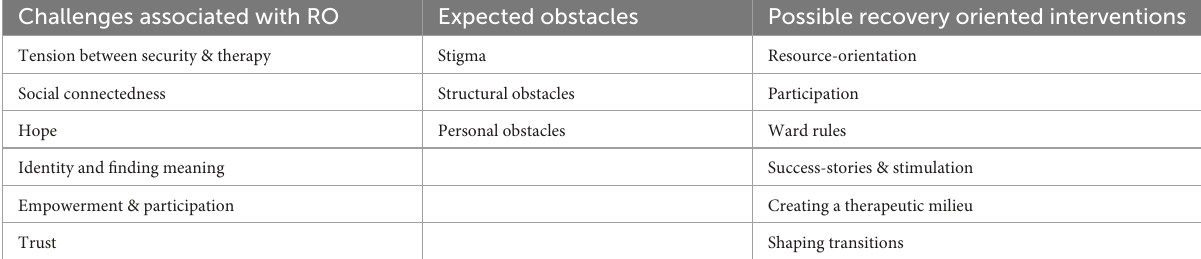
TABLE 2 Overview of themes and